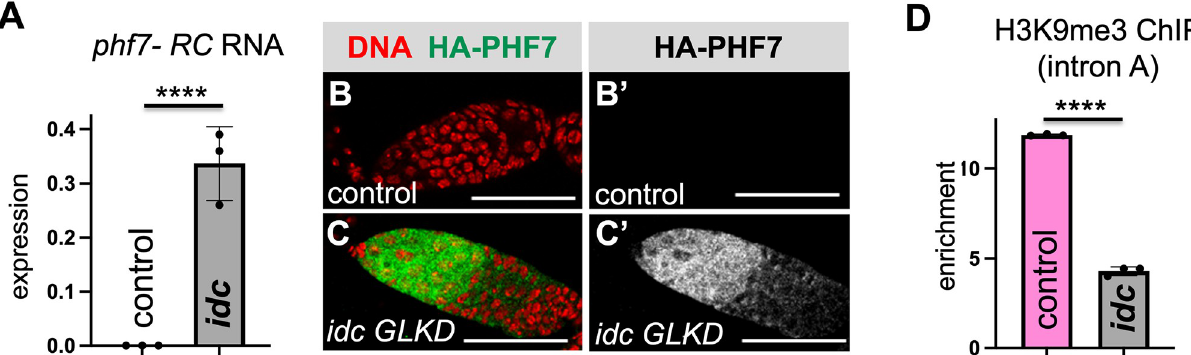
Fig 5. idc germ cell specific knock-down disrupts phf7 regulation. (A) idc GLKD germ cells ( nos > idc-RNAi ) express the testis phf7-RC transcript. RT- qPCR measures expression normalized to the total level of phf7 in RNA extracted from control (nos > white-RNAi ) and idc GLKD ( nos > idc-RNAi ) ovaries. The histograms show the mean ± SD of three biological replicates. (B, C) idc GLKD germ cells inappropriately express the PHF7 protein. Confocal images of ovaries dissected from control ( nos > white-RNAi ) and mutant ( nos > idc-RNAi ) females carrying an HA-PHF7 transgene and stained for HA (green, white in B’ and C’) and DNA (red). Scale bar 50 μ m. (D) H3K9me3 accumulation at the endogenous phf7 locus is reduced in idc GLKD ovaries. ChIP-qPCR measured H3K9me3 signal at the phf7 locus (primer in region A) in control ( nos > white-RNAi) and mutant ( nos > idc-RNAi ) ovaries. ChIP to input enrichment is normalized to rp49 . The histogram shows the mean ± SD of three biological replicates. A two-tailed Student’s t-test estimates statistical significance where ���� p < 0.0001.